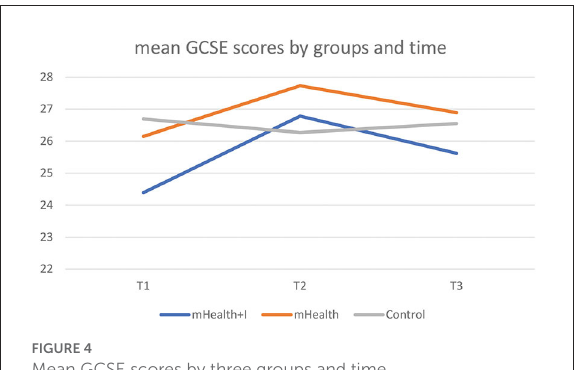
FIGURE4 Mean GCSE scores by three groups and time.